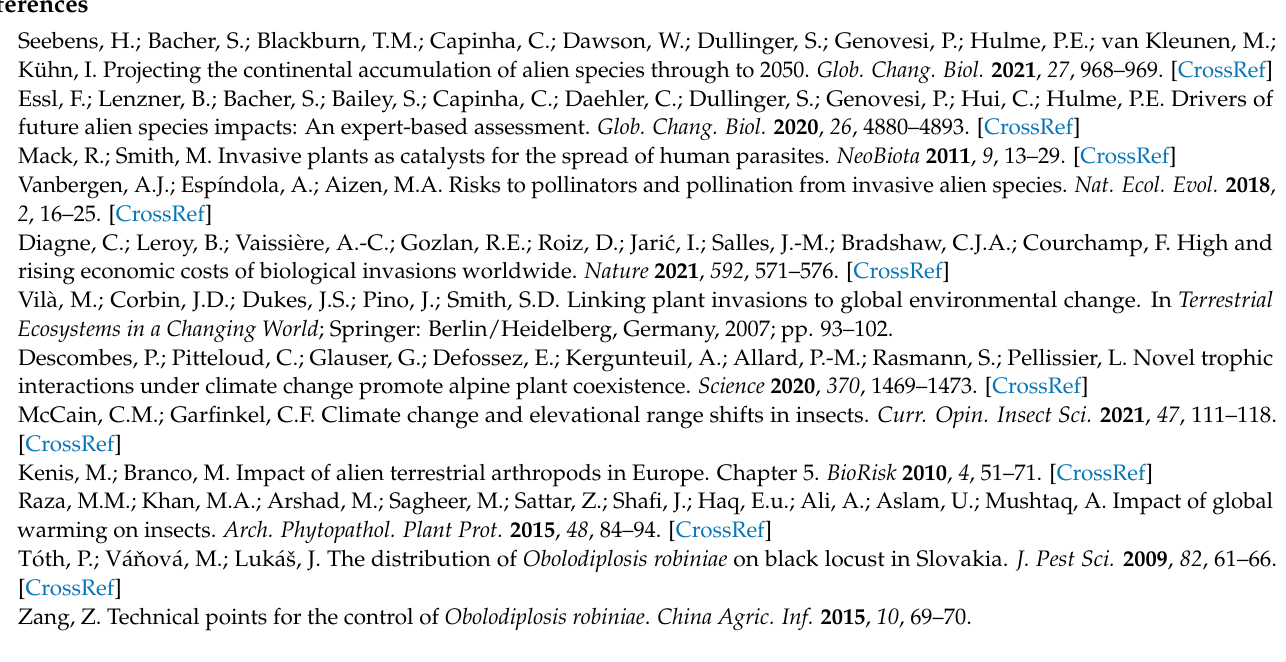
map of Climate heterogeneity; Figure S2: Pearson correlation coefficient; Figure S3: Performances of ecological niche model; Figure S4: Potential suitable area in 2050; Figure S5: Potential suitable area in 2070; Figure S6: Accuracy evaluation of model prediction; Figure S7: Bioclimatic variables analysis; Table S1: List of bioclimatic environmental variables; Table S2: The predictive accuracy; Table S3: Summary of values of bioclimatic